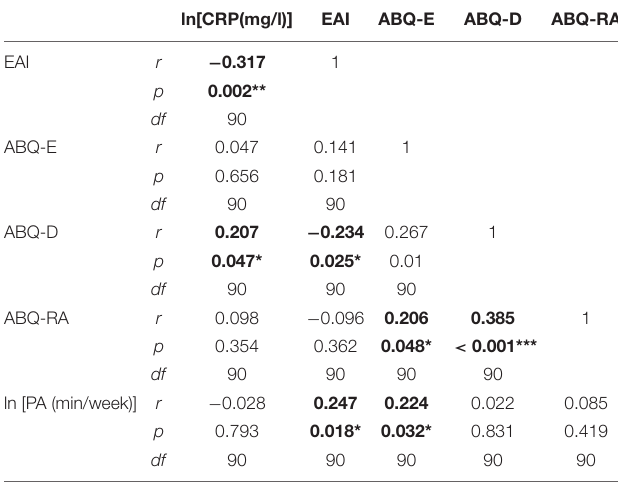
TABLE 3 | Results of the correlational analysis for the whole sample ( N =